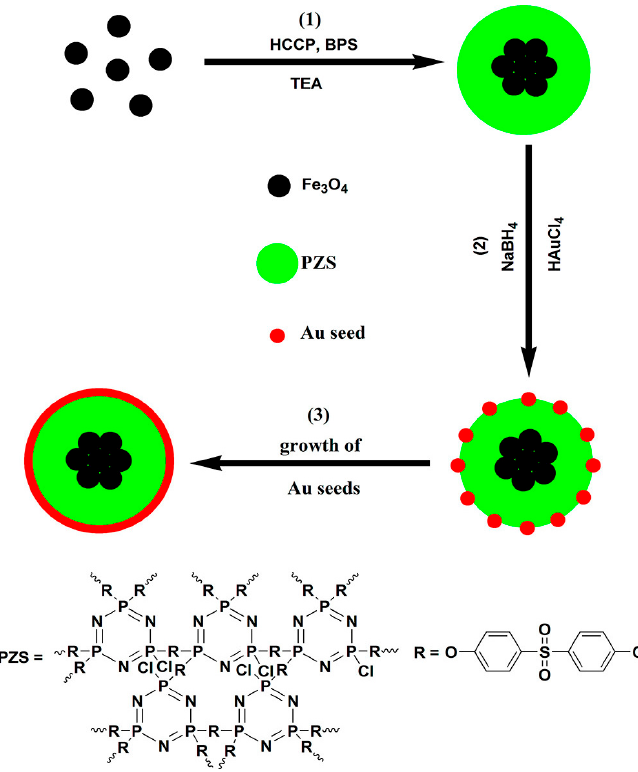
Figure 7. Preparation procedure of Fe3O4@PZS@Au Shells [71].